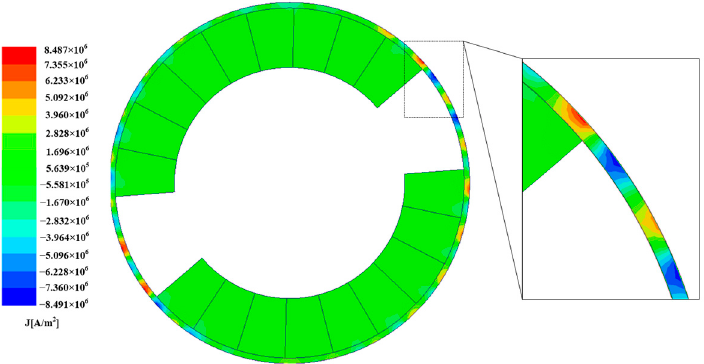
Figure 13. The eddy current density distribution of the permanent magnet and the 1.5 mm jacket.